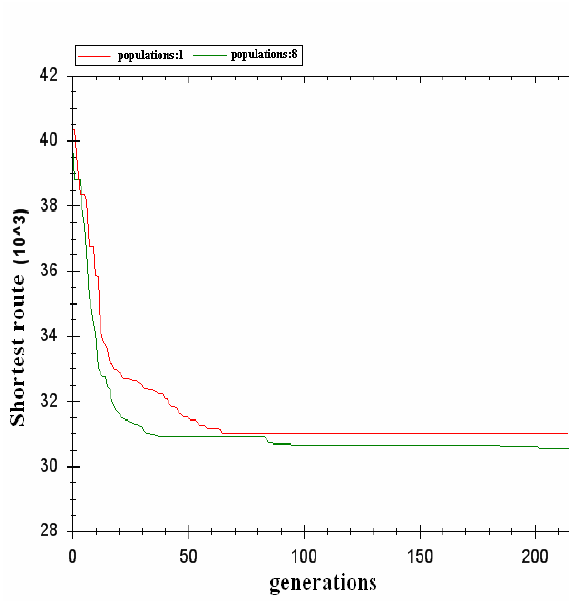
Figure12. The average result 4 of TSP benchmark instances Chn144 by different number of subpopulations